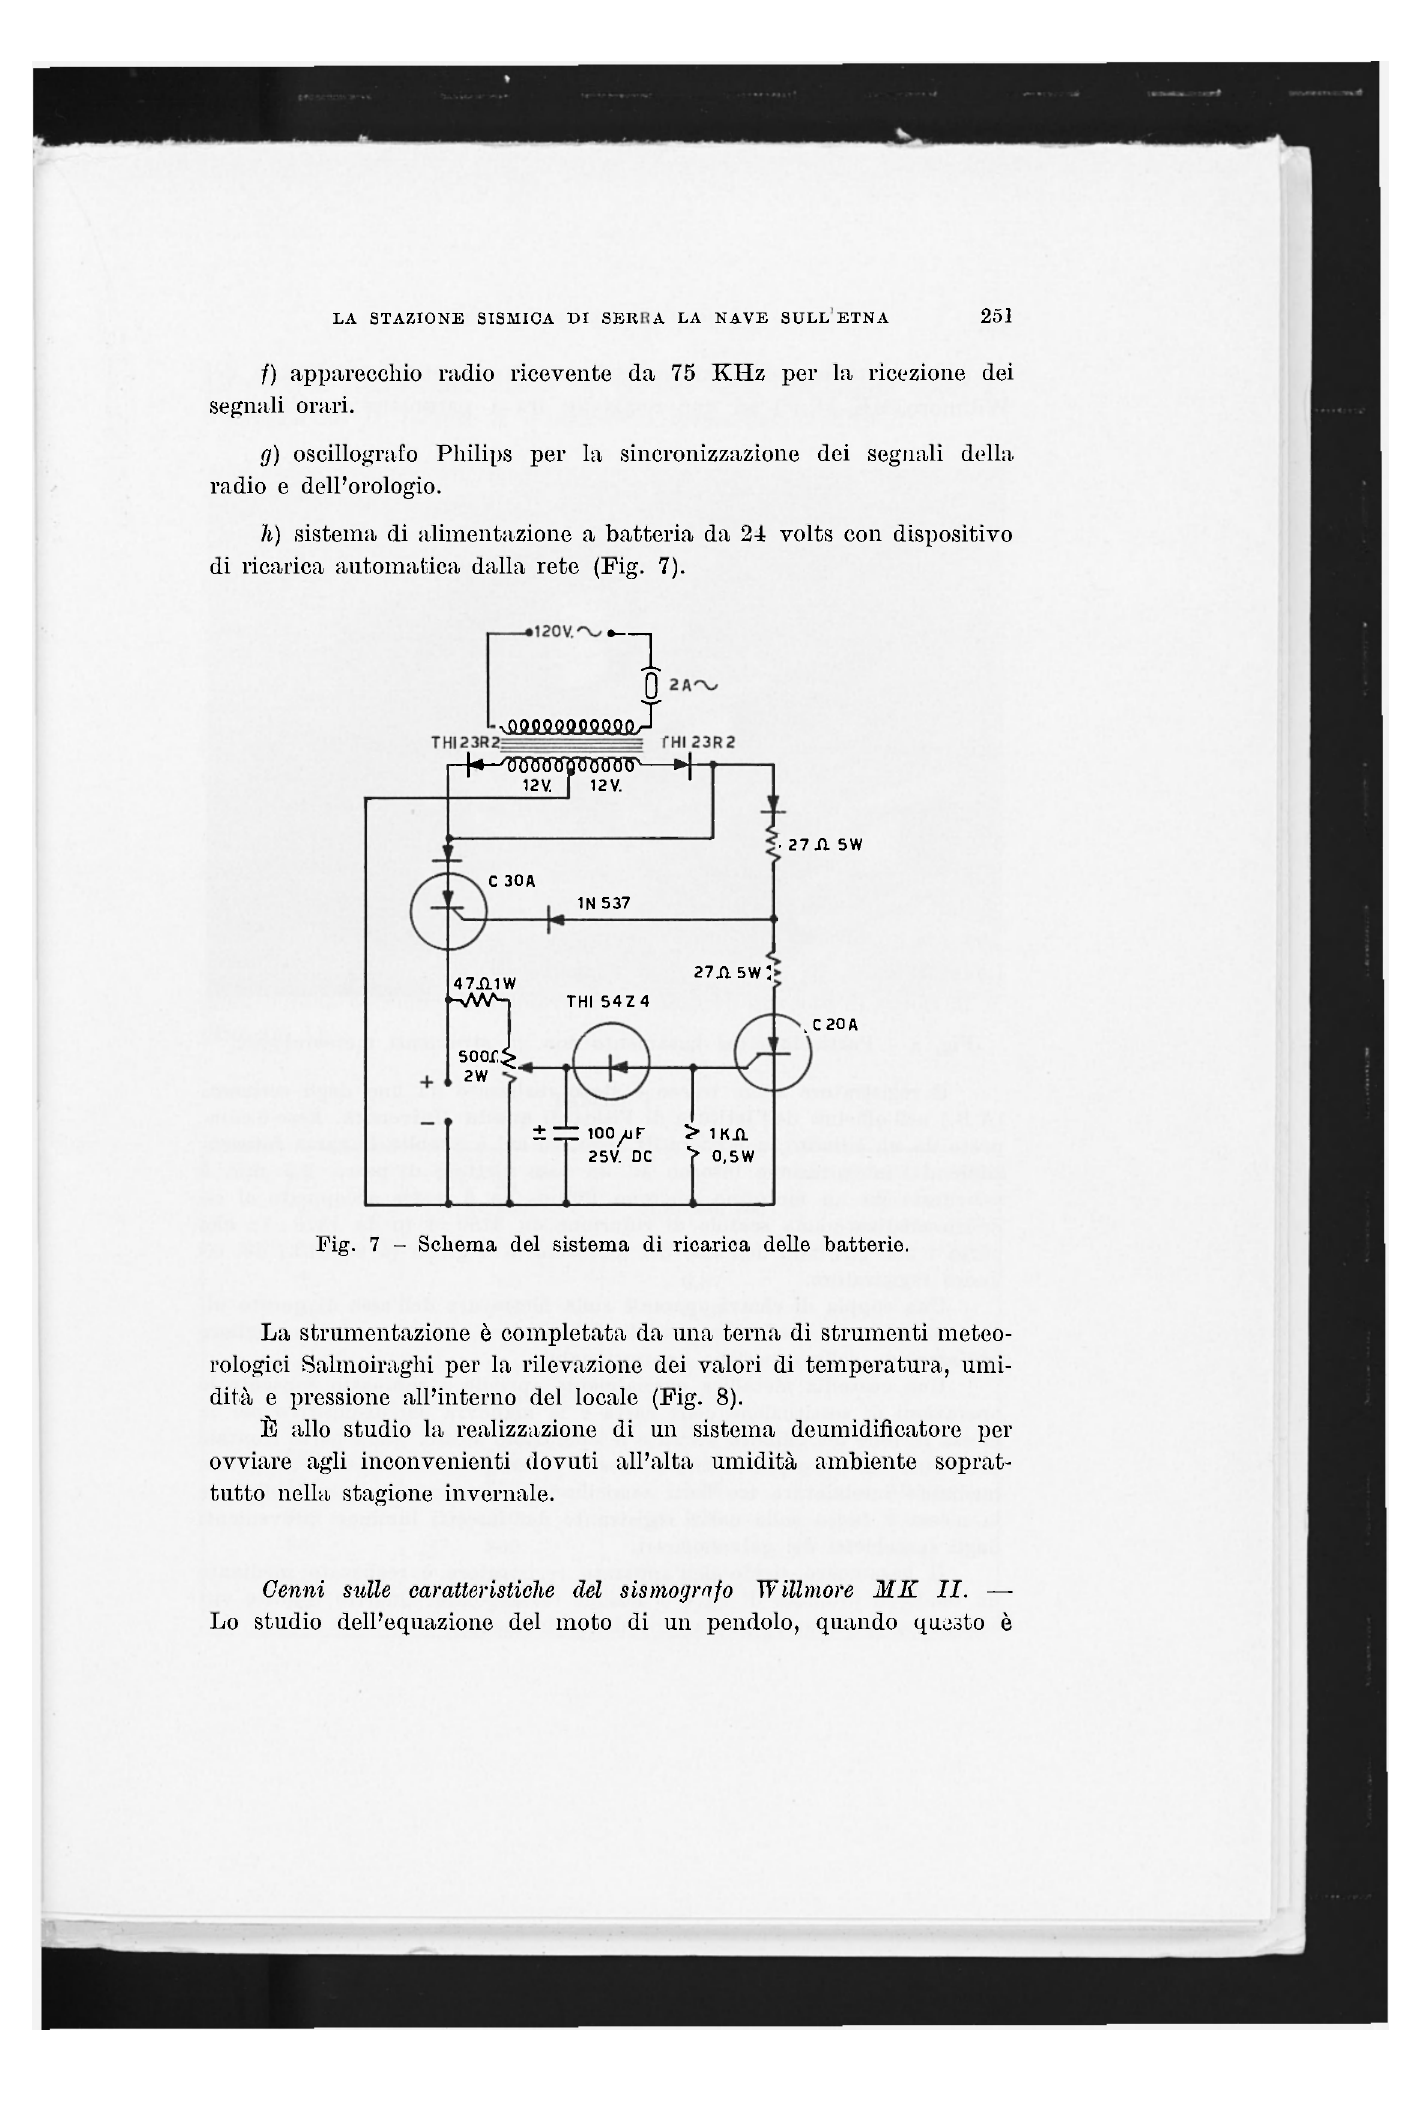
Fig. 7 - Schema del sistema di ricarica delle